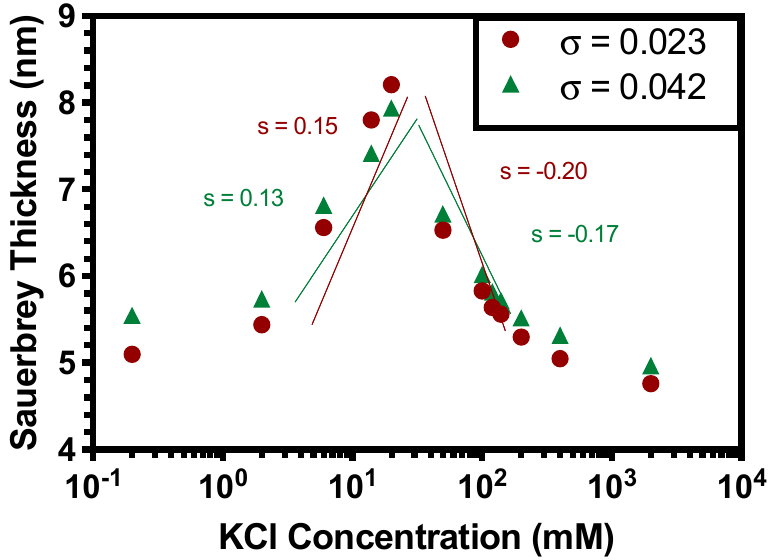
Figure 1. Height (i.e., Sauerbrey thickness) at various salt concentrations for a 39 kDa PAA brush at grafting density σ = 0.023 chains/nm 2 (red circles) and σ = 0.042 chains/nm 2 (green triangles) at pH 4.2, below the pKa (~5). Log-log fits demonstrate the scaling exponents s for the Osmotic Brush (OB) regime (left slopes) and Salted Brush (SB) regimes (right slopes).